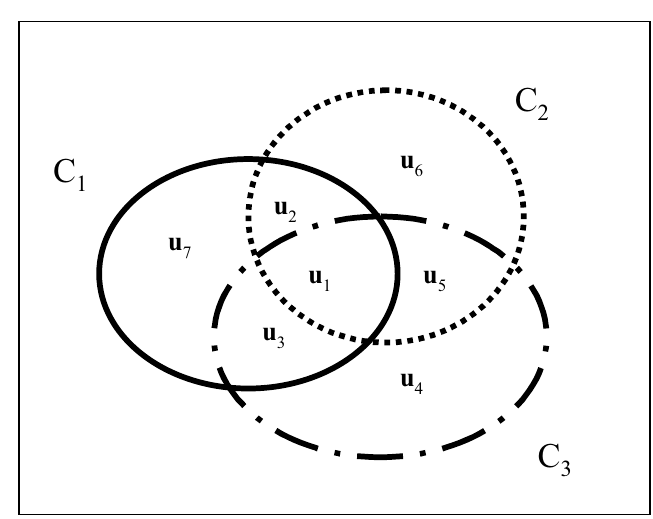
Figura 1 – Rappresentazione dei profili in presenza di 3